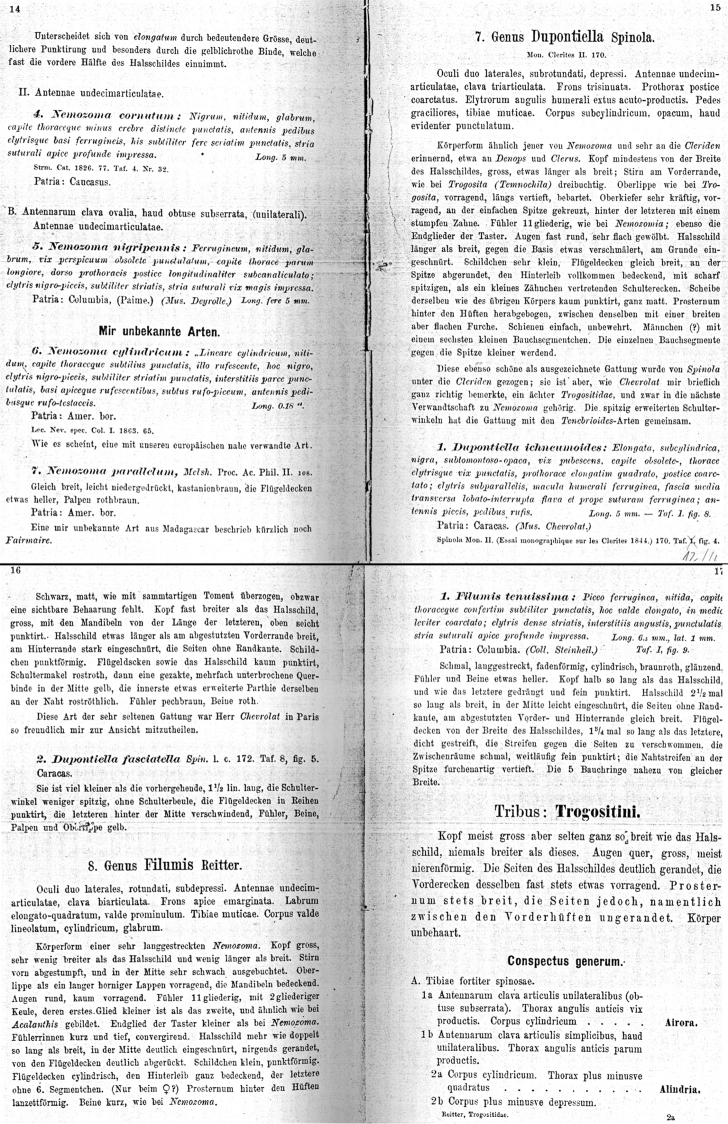
A facsimile of Reitter 1876: 14–17. Author’s remarks on the genus Dupontiella and the both species, Dupontiella ichneumonoides and Dupontiella fasciatella.